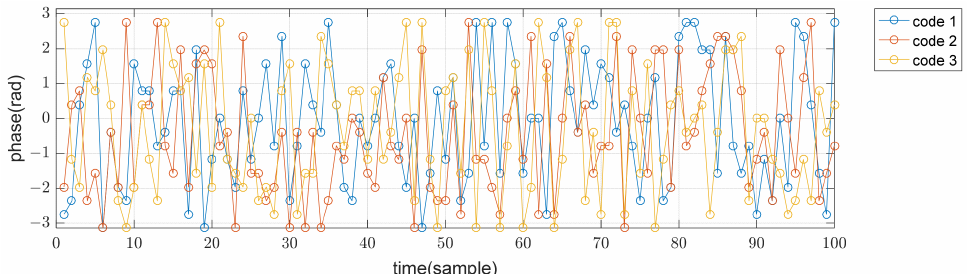
Figure 5. Phase of codes in time